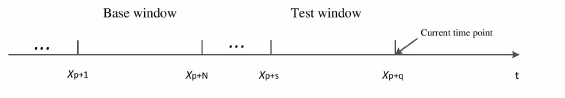
Figure 7. Sliding